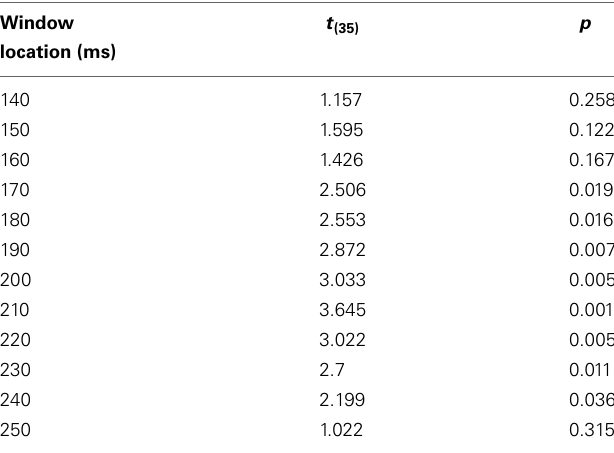
Table 3 | The comparison between the groups’ DT computed from the Visual modality time windows taken from the time area of